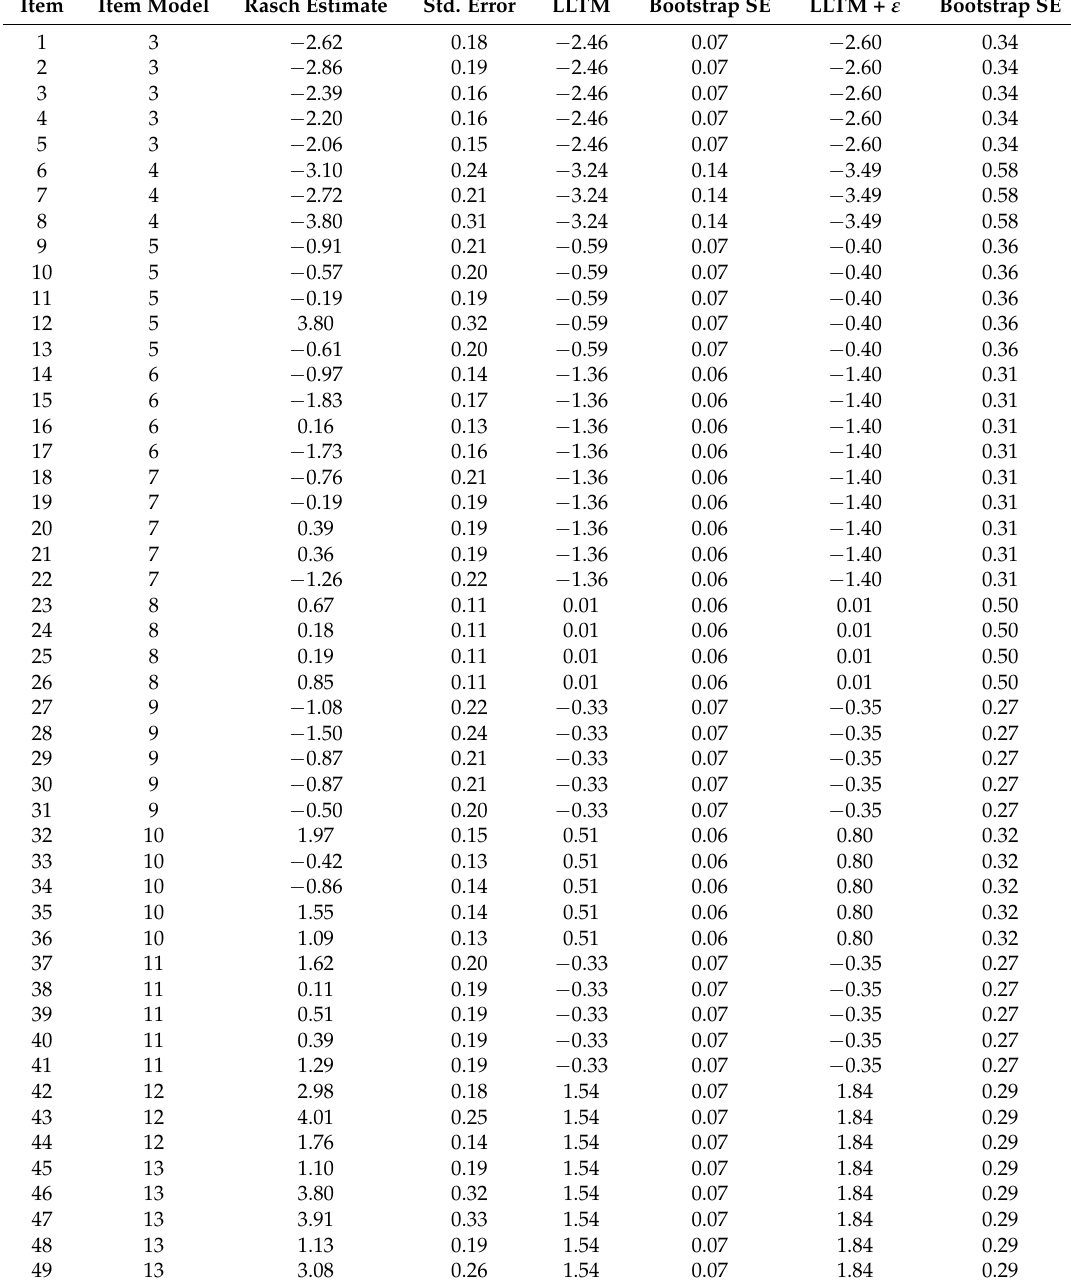
Table 8. Rasch, LLTM and LLTM + ε item difficulty parameter estimates and standard